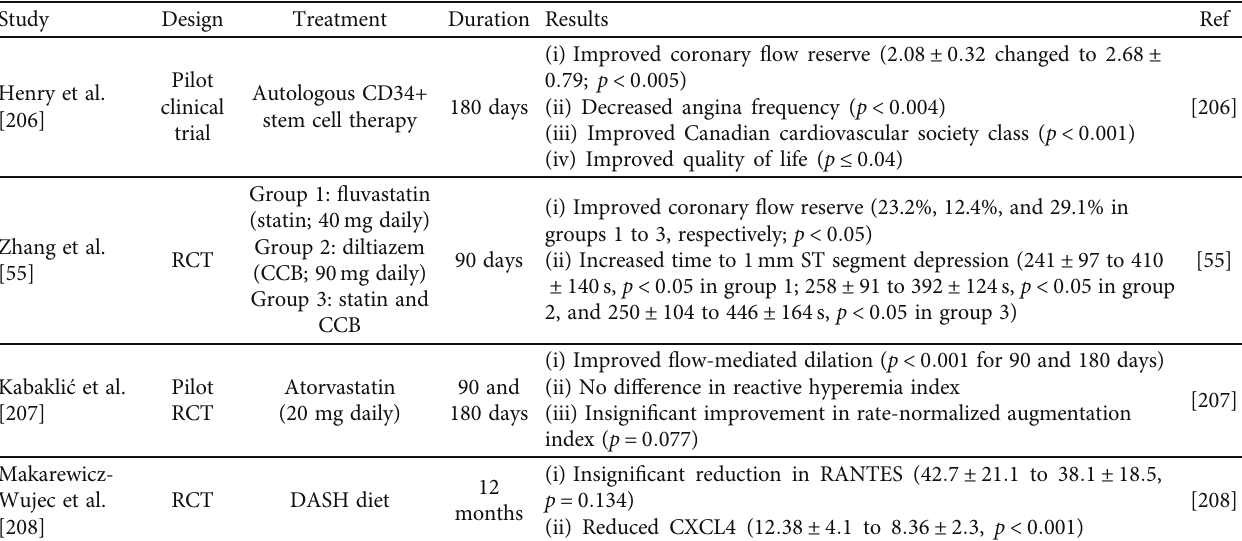
Table 1: Recently-published articles on management of